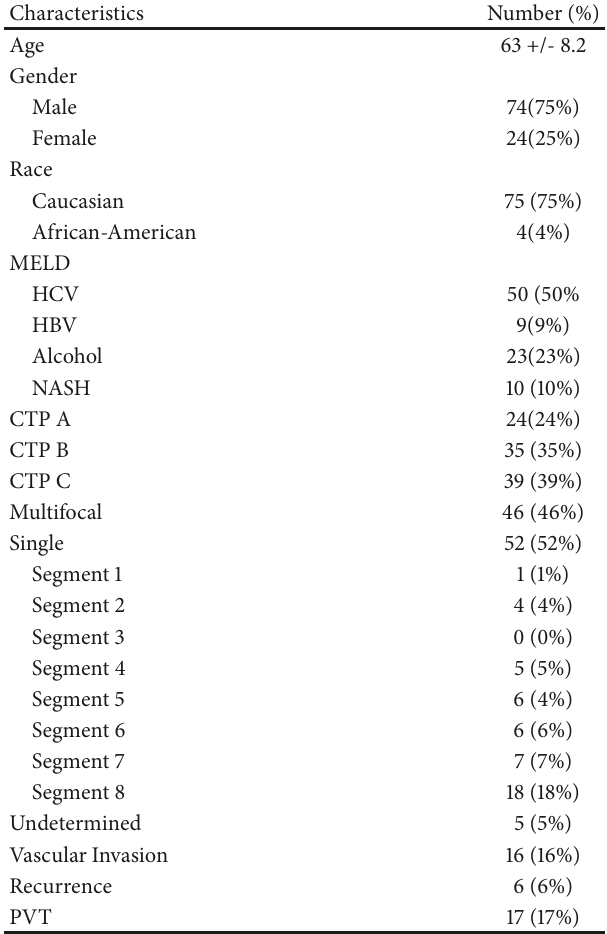
Table 1: Baseline characteristics of the study